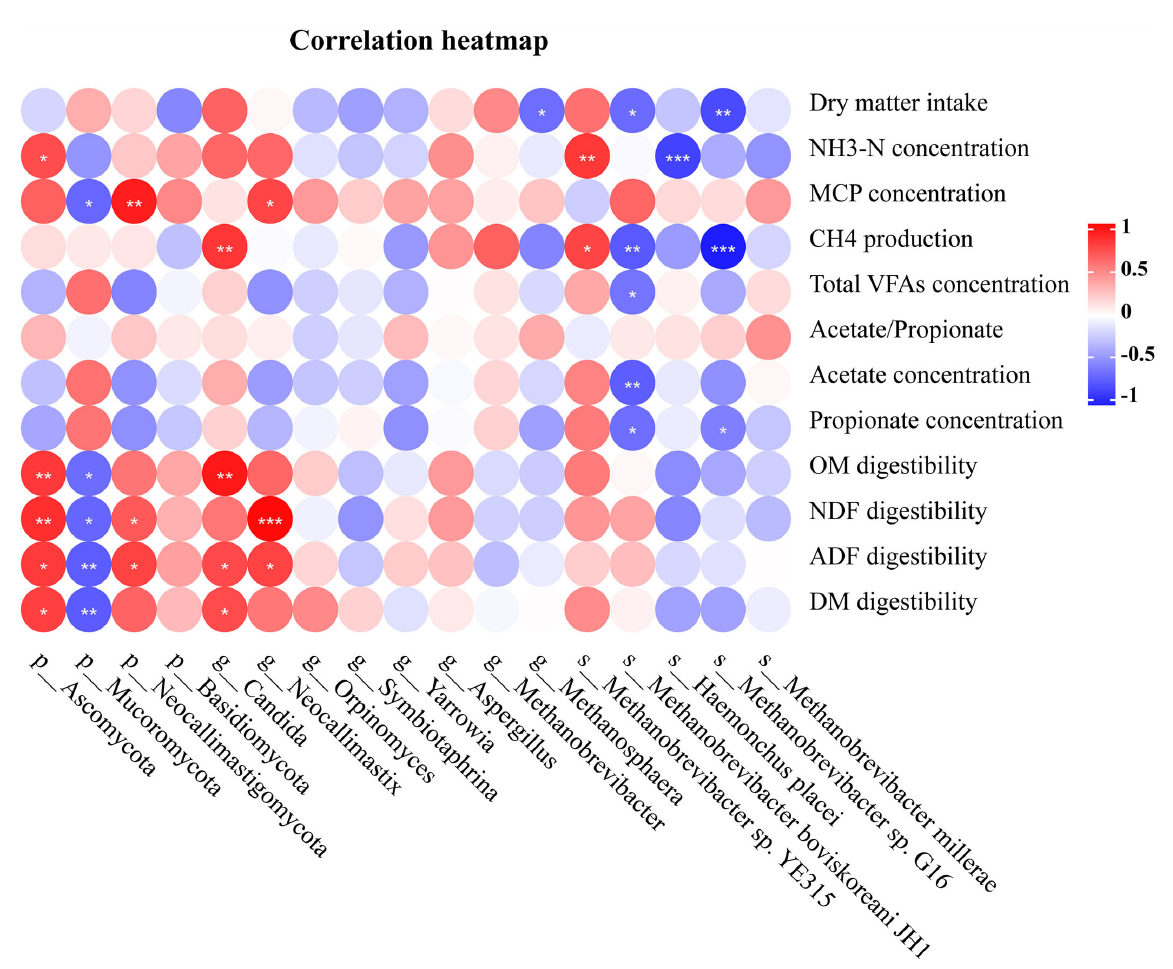
to 25.9%, which was consistent with the results of this